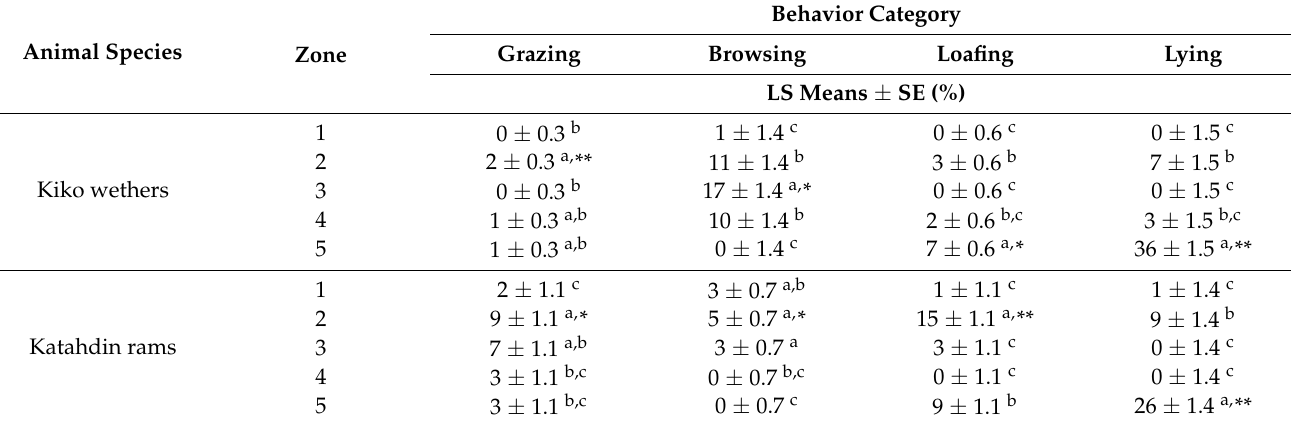
Table 2. Diurnal (dawn–dusk) time spent by Kiko wethers and Katahdin rams in woodland, June–August 2018. Behavior Category Animal Species Zone Grazing Browsing Loafing Lying LS Means ± SE (%)